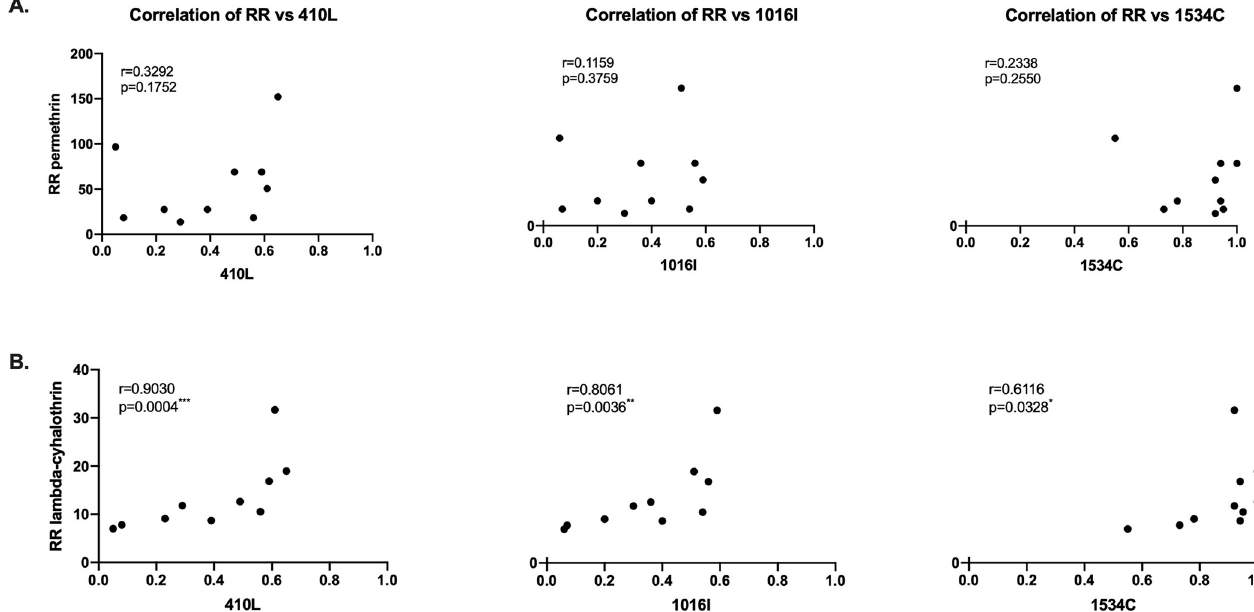
Fig 5. Spearman Correlation test (RR) for permethrin (A) and lambda-cyhalothrin (B) and the frequency of the mutated alleles for positions 410L, 1016I, and 1534C of the Colombian populations of Aedes aegypti evaluated. The Spearman correlation r and p values are shown for each correlation ( ��� = p < 0.001, �� = p < 0.01, � = p < 0.05).